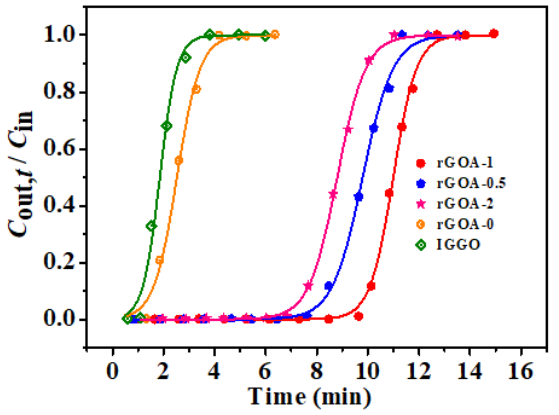
Figure 7. Breakthrough curves of different adsorbents for L2. Table 2. Adsorption parameters of different adsorbents for L2 a